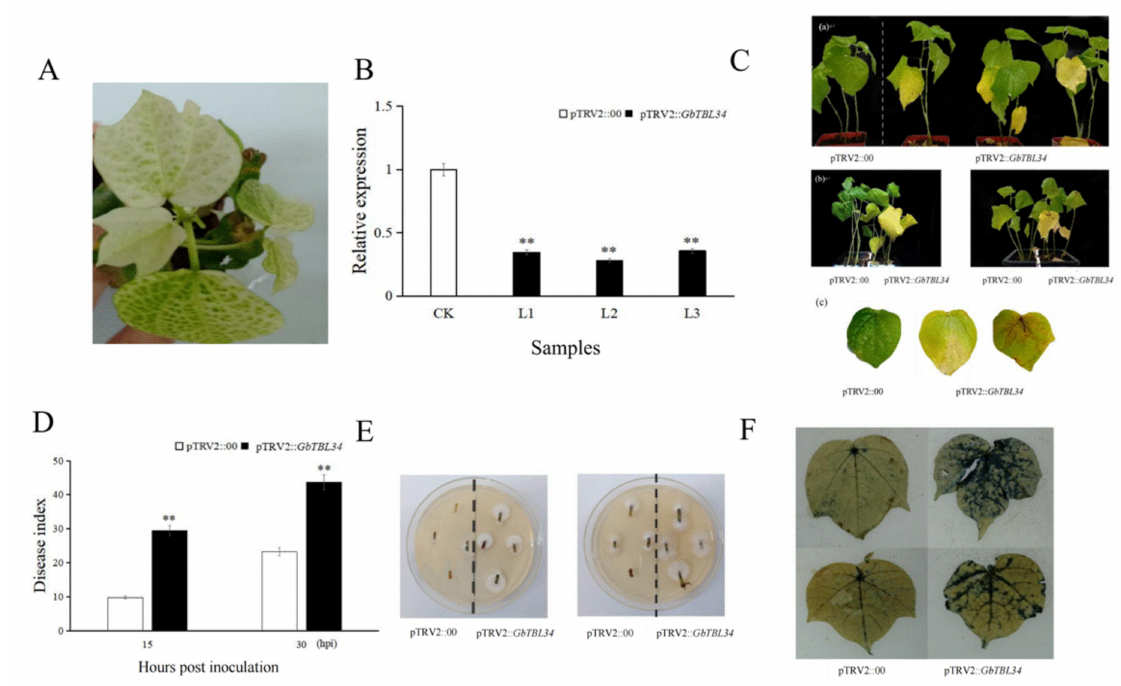
Figure 7. Analysis of the function of cotton TBL34 using VIGS. ( A ). Phenotype of cotton seedling infiltrated with pTRV2: GhPDS ; ( B ). Expression levels of GbTBL34 in silencing plants and control. CK represents the control; L1, L2, and L3 represent the three repeats of the silenced gene plants; ( C ). VIGS phenotype: ( a ) means that the control and infiltrated pTRV2: GbTBL34 plants were planted in different nutrition pots; ( b ) means that the control and infiltrated pTRV2: GbTBL34 plants were planted in the same nutrition pots; ( c ) means that the differences of leaves between the control and infiltrated pTRV2: GbTBL34 plants; ( D ). Disease index of the control and infiltrated pTRV2: GbTBL34 plants; ( E ). The result of Verticillium dahliae recovery assay; ( F ). Trypan blue staining. Note: pTRV2 :: 00 means plants injected with empty vector; pTRV2 :: GbTBL34 means plants that silence GbTBL34 gene; The significant difference is Student ’s t test; ** p <